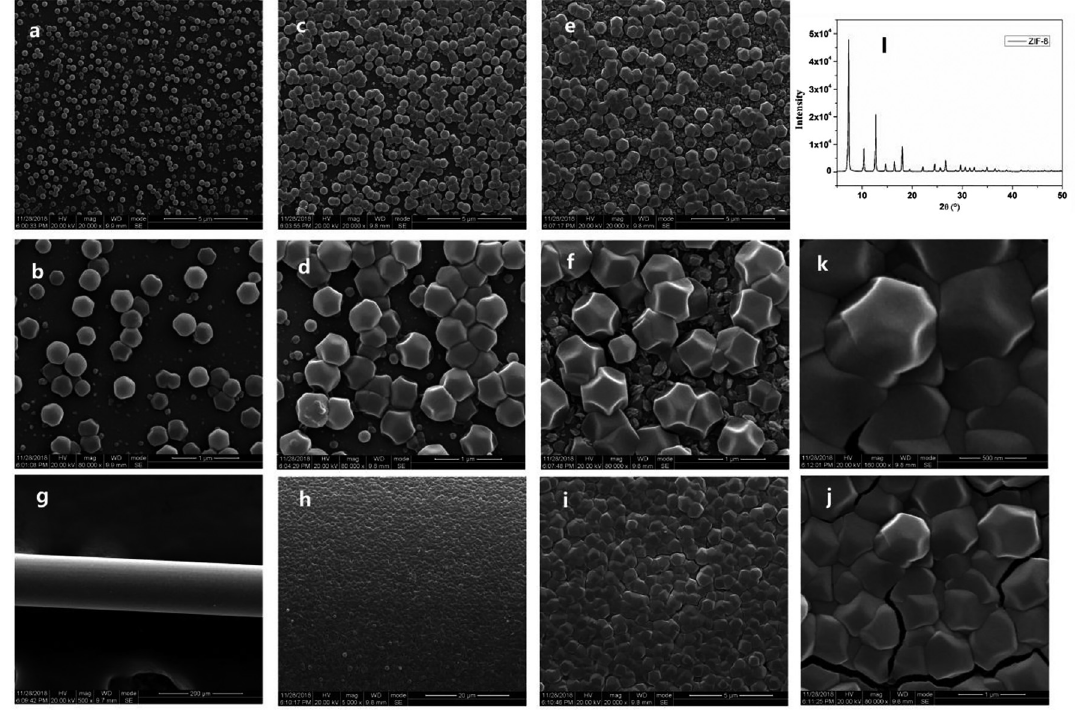
Figure 1: Scanning electronic images (SEM) images of zeolitic imidazole frameworks (ZIF)-8 on fibers after one cycles (a and b), two cycles (c and d), three cycles (e and f), and seven cycles (g – k), and X-ray diffraction (XRD) of powder ZIF-8